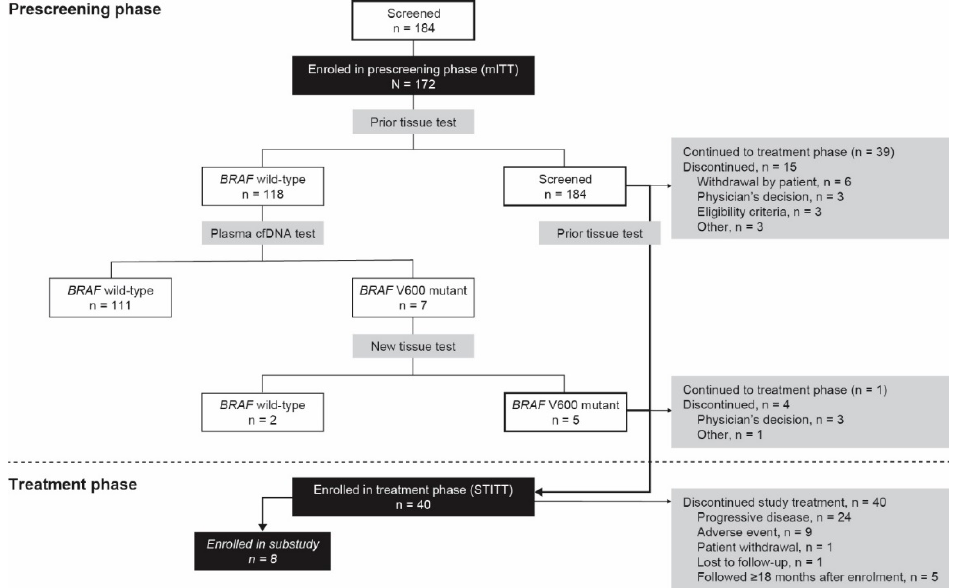
Figure 1. Patient disposition. mITT, modified intention-to-treat; STITT, study treatment intention-to-